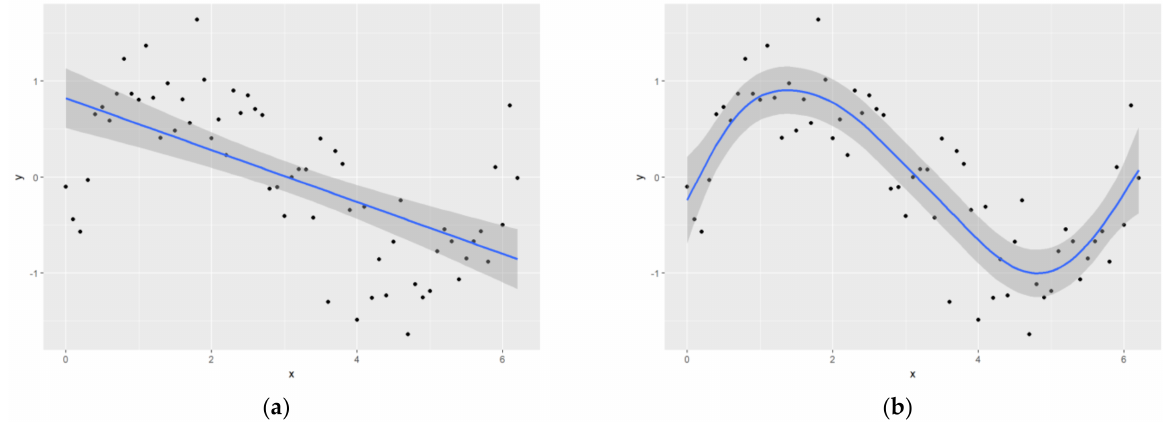
Figure 10. GAM model explained with comparison to regression, ( a ) linear regression; ( b ) generalized additive model